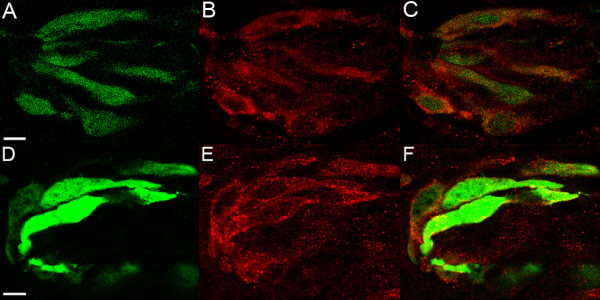
Laser scanning confocal micrographs (LCSMs) of mouse circumvallate taste buds show that GFP is an accurate reporter of protein. Panels A-C show sections from transgenic mice expressing GFP under the control of the T1R3 promoter. Green denotes T1R3 GFP expression (A, C) and red shows T1R3-like-immunoreactivity (LIR) (B, C). Panels D-F show sections taken from mice expressing GFP under control of the TRPM5 promoter. Green denotes TRPM5 GFP expression (D, F) and red shows TRPM5-LIR (E, F). Scale bar is 20 μm.